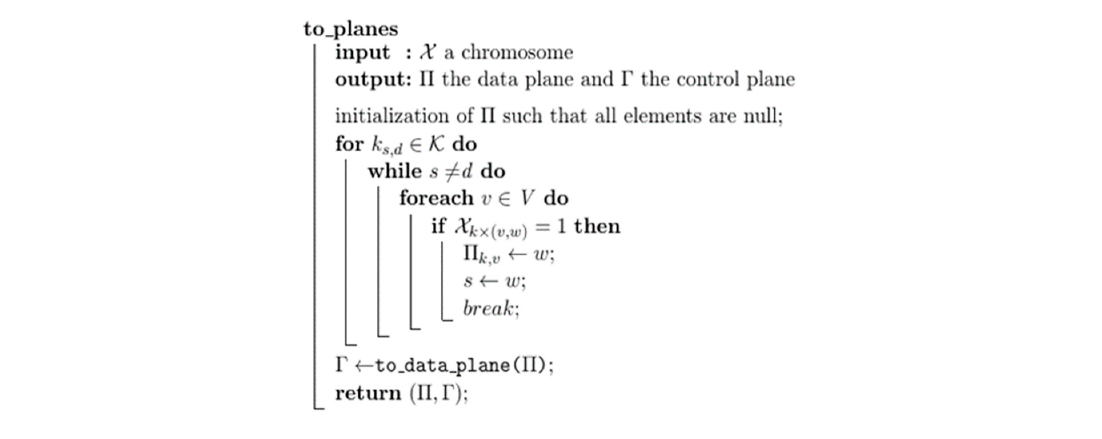
Algorithm 1. Retrieval of data and control plane from chromosome.